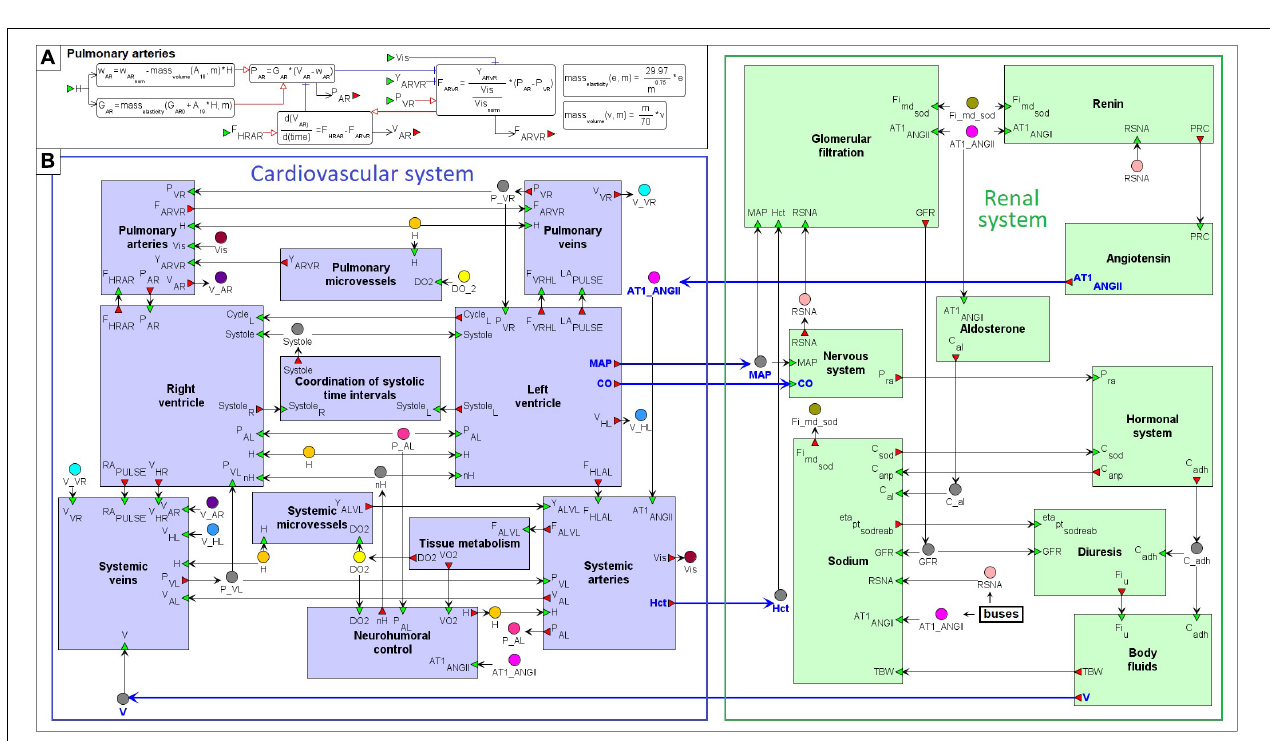
FIGURE 5 | Modular agent-based physiological model of the cardiovascular and renal systems. (A) An example of the “Pulmonary arteries” module representation. (B) The model implemented in the BioUML platform is divided into nine modules responsible for the kidney function (green) and 11 modules that simulate dynamics of the cardiovascular system (purple). Blue arrows indicate directed connections between the renal and cardiovascular sub-diagrams ( Figure 4 ). For visual simplicity of the diagram, we added transitional nodes (busses) which are used for connections between modules. The busses corresponding to one variable can be located far apart in the diagram. A complete list of equations for each module is given in the Supplementary Appendix Table A2